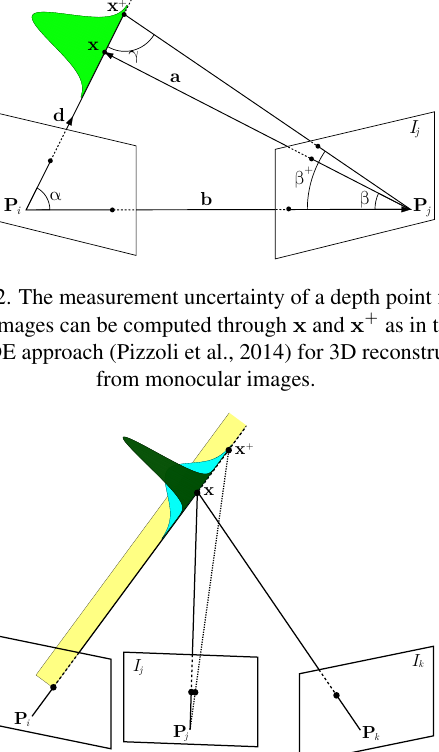
Figure 3. Illustration of the reduction of the uncertainty in the estimate about the 3D point location given a third